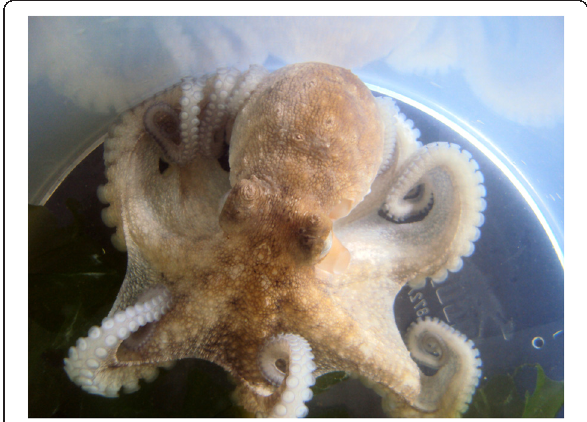
Figure 1 Octopus vulgaris , this animal caused the injury described in the text.